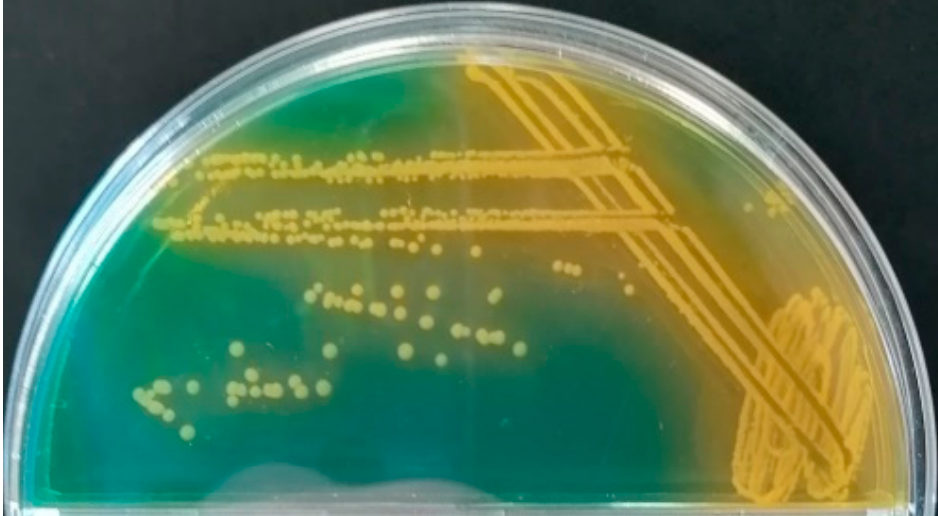
Figure 2. Subculture of a single colony on TCBS with 2% NaCl.